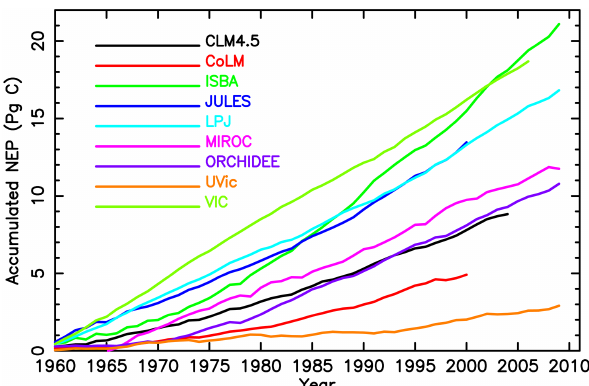
Figure 11. Cumulative NEP in PgC over the simulation period for each